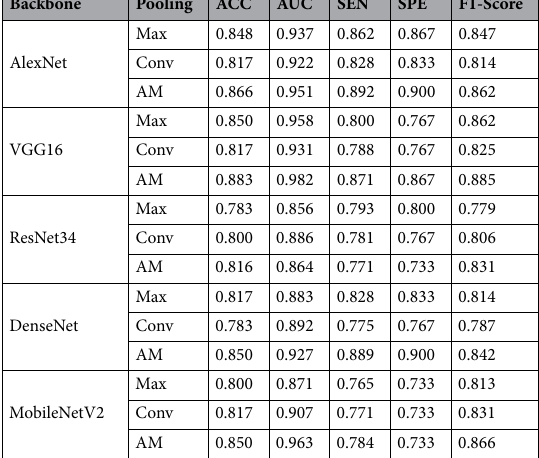
Backbone Pooling